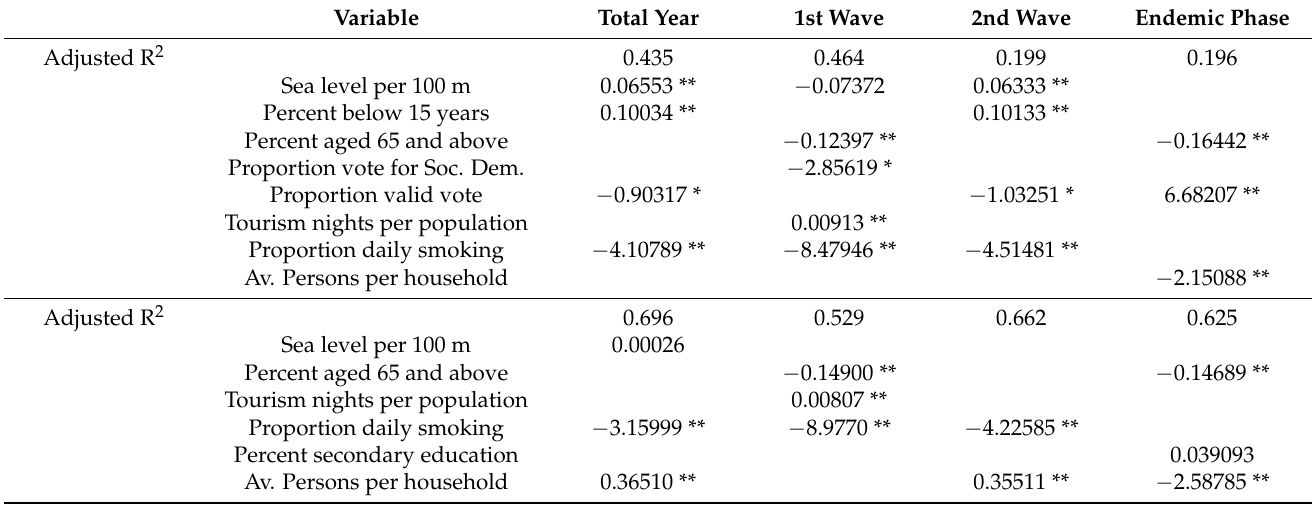
Table 2. Coefficients of the final linear regression model for ln (1 + cumulative number per 100,000). Upper part: federal country not considered; lower part: federal country